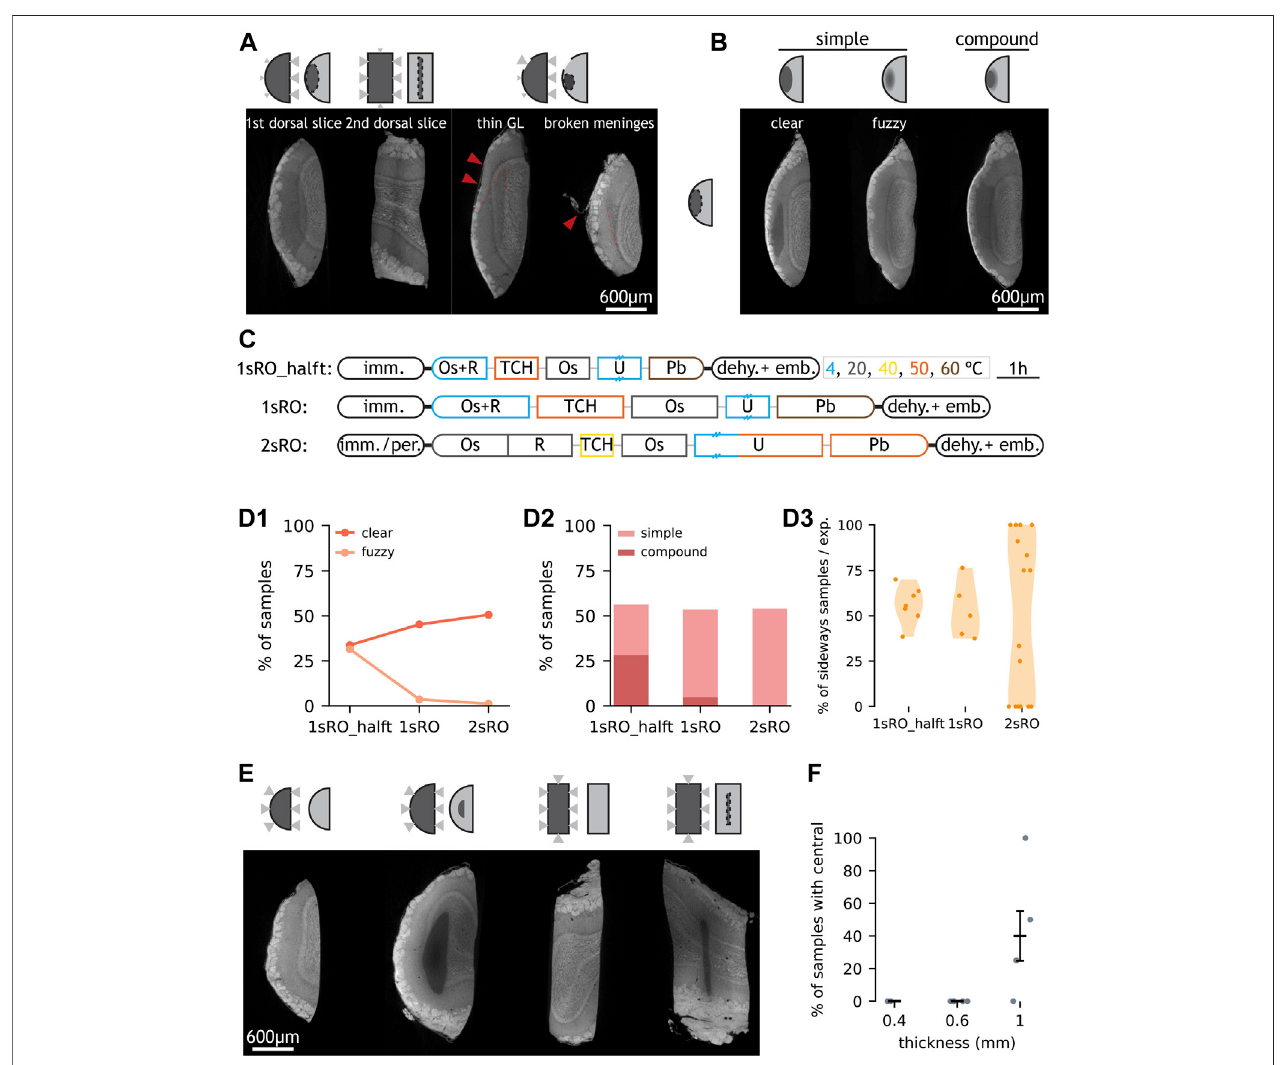
FIGURE 2 | Occurrence and proposed mechanism of “ sideways ” and “ central ” artefacts. (A) LXRT images of four samples with “ sideways ” and schematics of hypothesised causes. In the last two samples, the positions of thin GL and broken meninges are highlighted with arrowheads, and part of the “ sideways ” boundary is marked with a dashed line. In schematics, the size of triangles represent the diffusion rate. (B) Subdivision of “ sideways ” by boundary type and by complexity. (C) Summary of three SPPs. Staining is split into key steps. Length and colour of staining steps represent incubation time and temperature, respectively. Double dash on box represents overnight incubation. Thin lines connecting staining reagents represent water washes. (D1) Occurrence rate of “ sideways ” with “ clear ” and “ fuzzy ” boundaries in the three SPPs. (D2) Occurrence rate of “ simple ” or “ compound ” “ sideways ” in the three SPPs. (D3) Penetrance of “ sideways ” in experiments processed with the three SPPs. Each dot represents one experiment. (E) Samples with (2nd and 4th, 1 mm-thick) and without (1st and 3rd, 0.6 mm-thick) the “ central ” artefact. (F) Occurrence of “ central ” depends on slice nominal thickness. Each data point represents the % of samples with “ central ” artefact within an experimental batch (all samples stained with 2sRO protocols). Error bar shows mean ± standard error of mean. Abbreviations: GL: glomerular layer, imm: immersion, per: perfusion, dehy: dehydration, emb: embedding, Os: osmium tetroxide, R: potassium ferrocyanide, TCH: thiocarbohydrazide, U: uranyl acetate, Pb: lead aspartate. Scale bars are shared across all images in the same